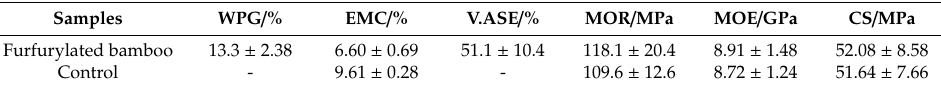
Table 2. Physical and mechanical properties of untreated and furfurylated bamboo.